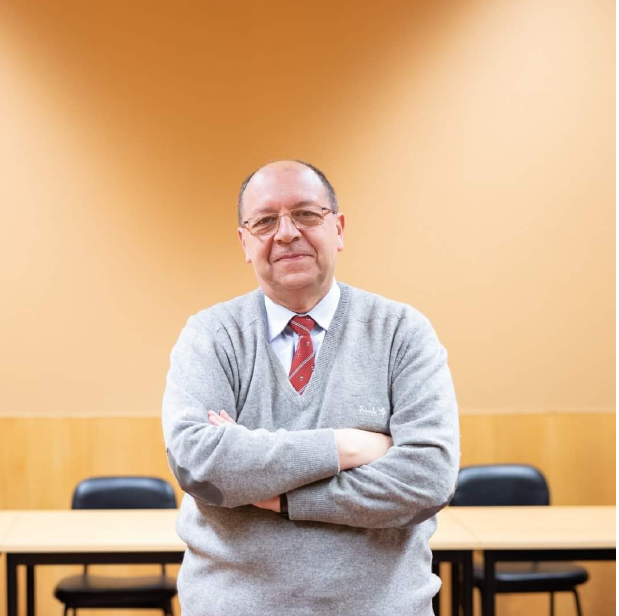
Figure 1. Prof. Tenreiro Machado (2020) at the Dept. of Electrical Engineering, Institute of Engineering, Polytechnic Institute of